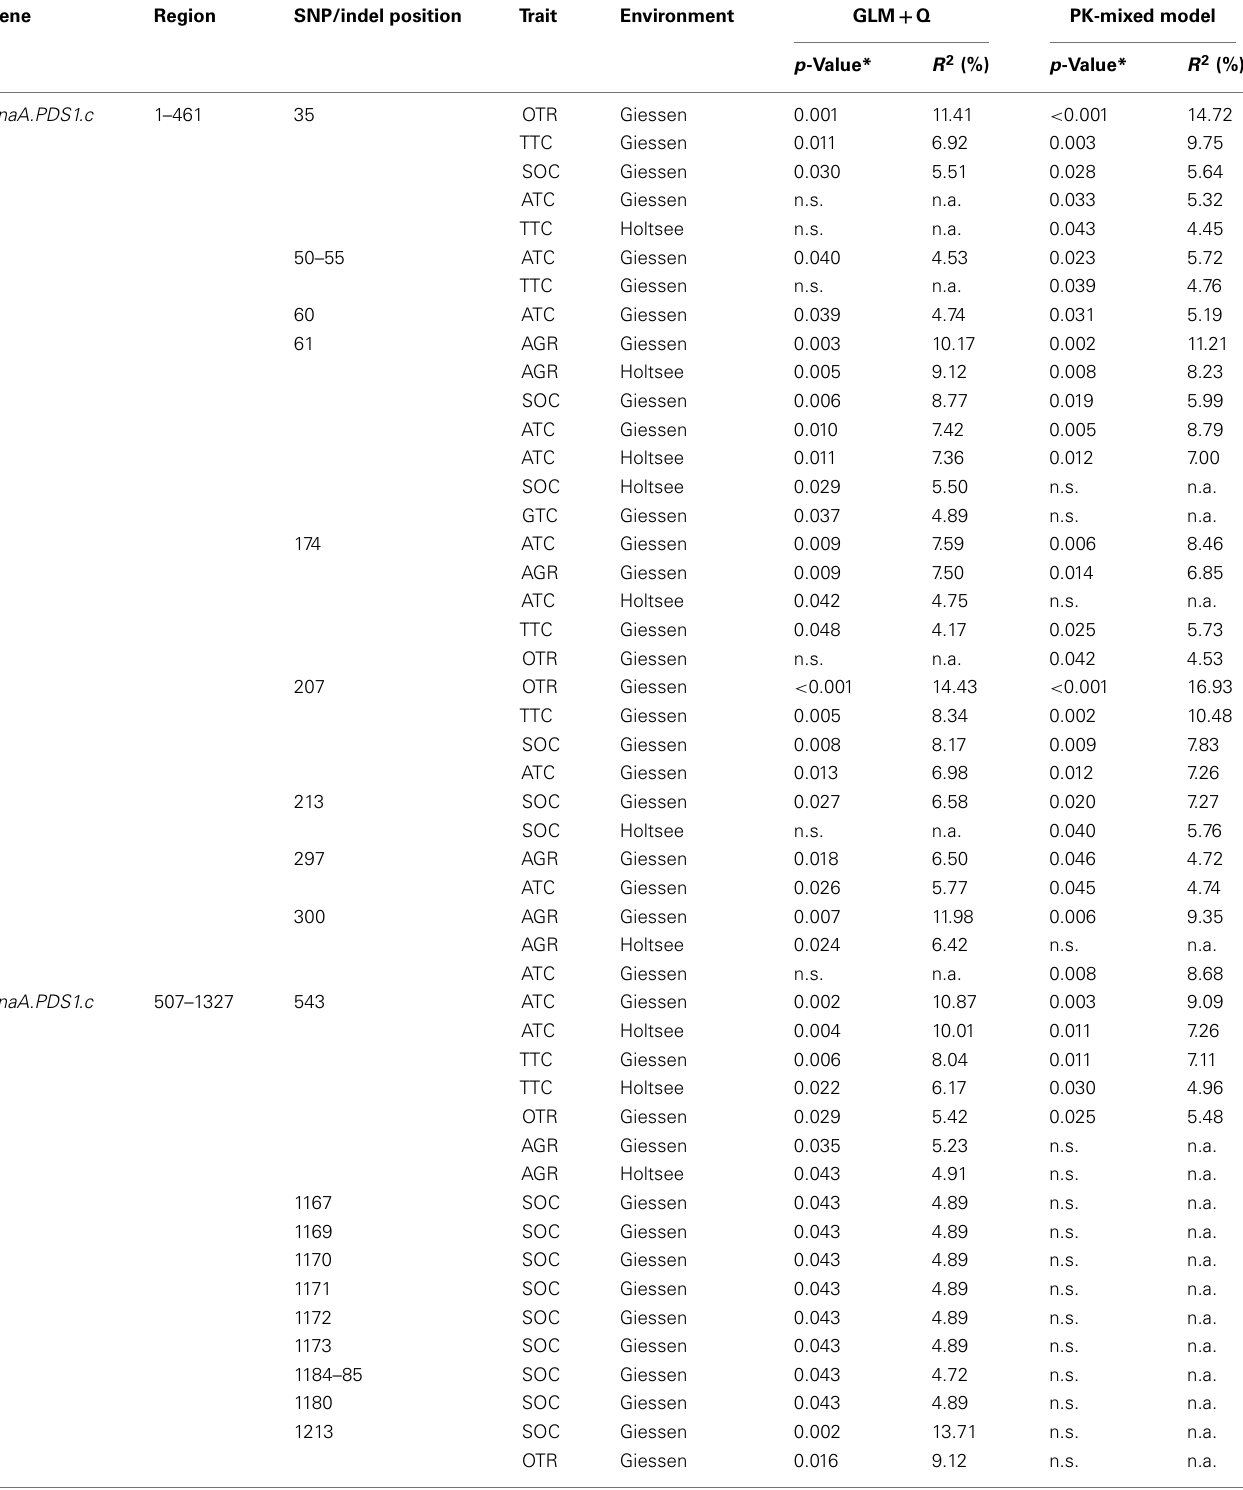
Table 8 | Polymorphisms of three tocopherol candidate regions of the 96 B. napus accession panel significantly associated ( p < 0.05) with tocopherol and seed quality traits and their percentage on phenotypic variation evaluated by GLM + Q and PK-mixed model.